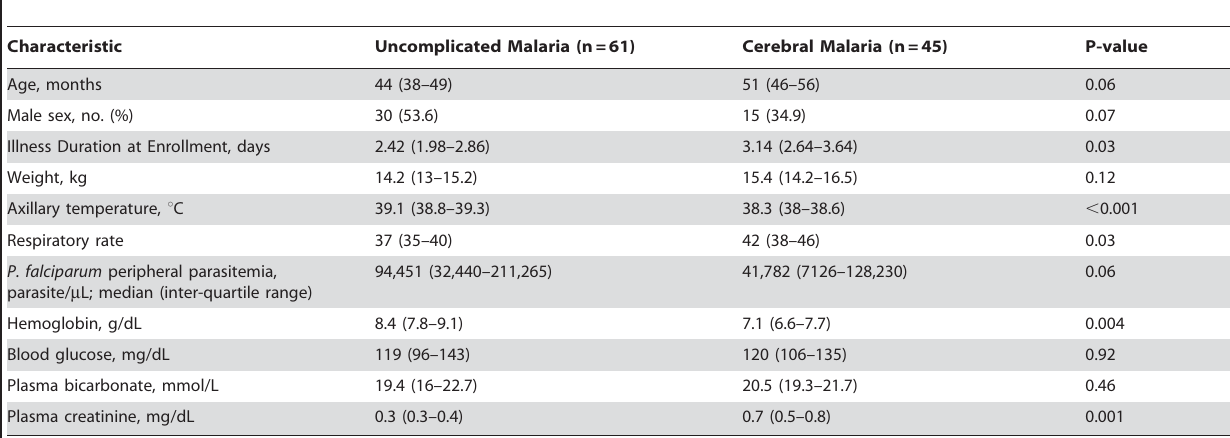
Table 1. Baseline characteristics of children with uncomplicated malaria and cerebral malaria.